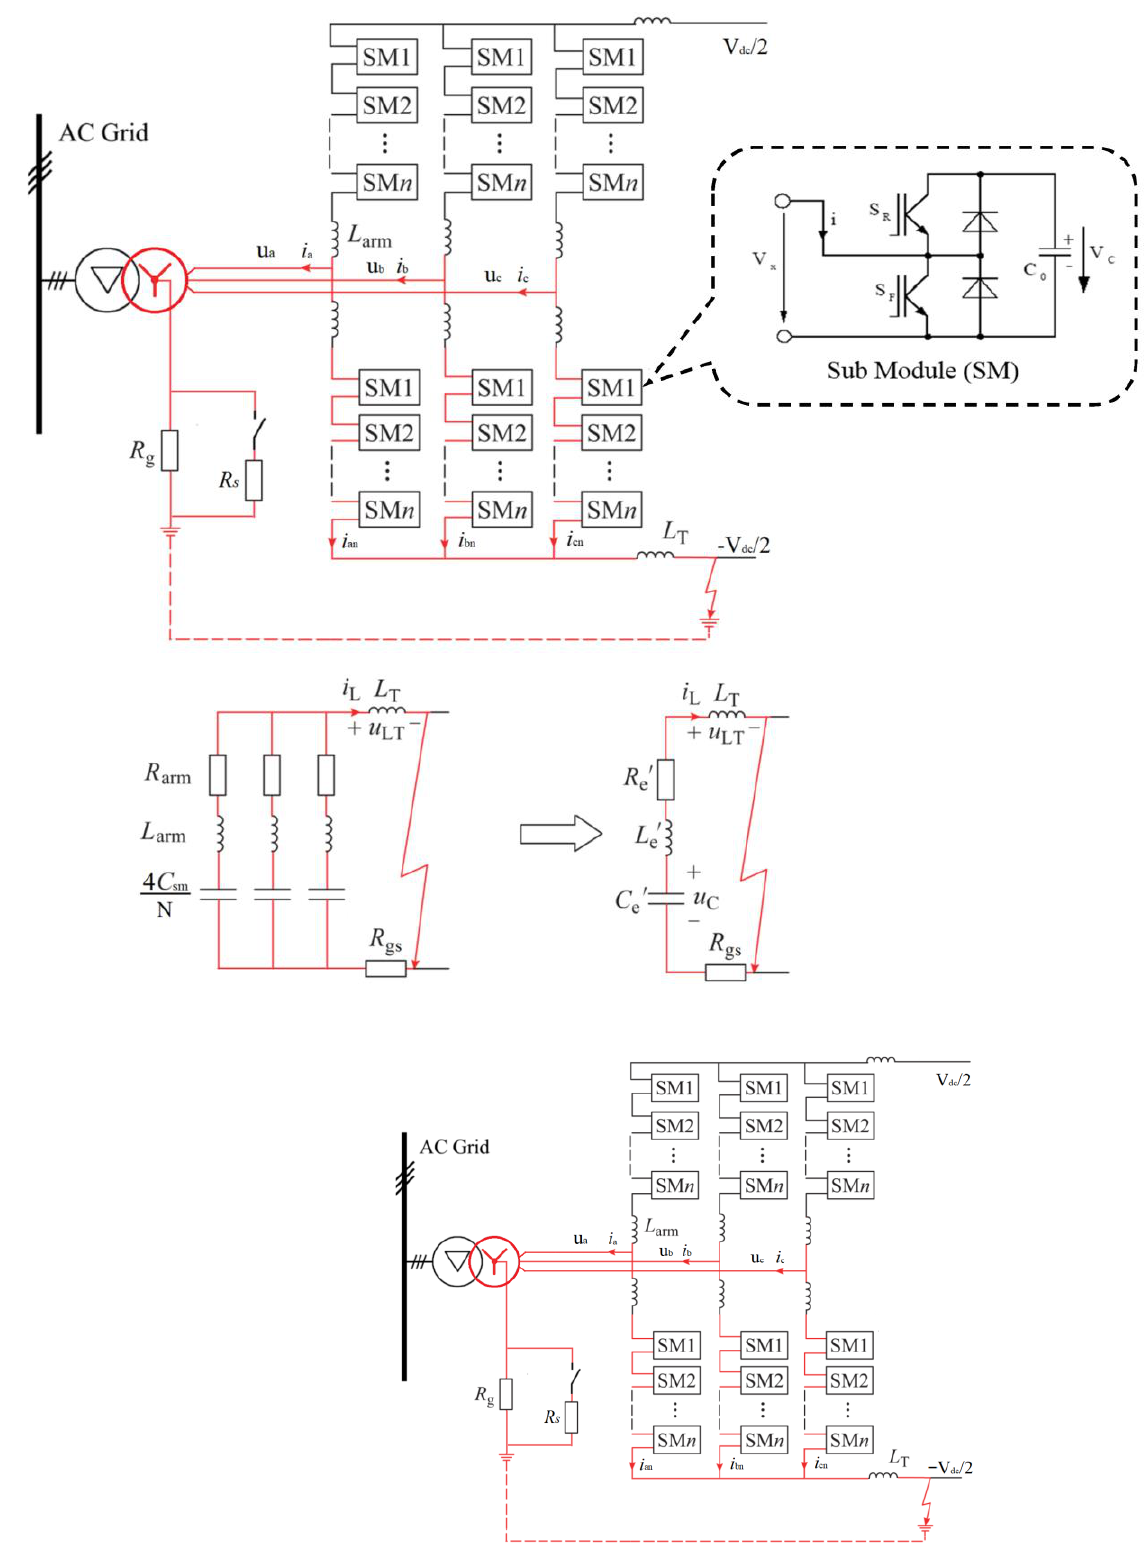
Figure 2. SPG fault model of